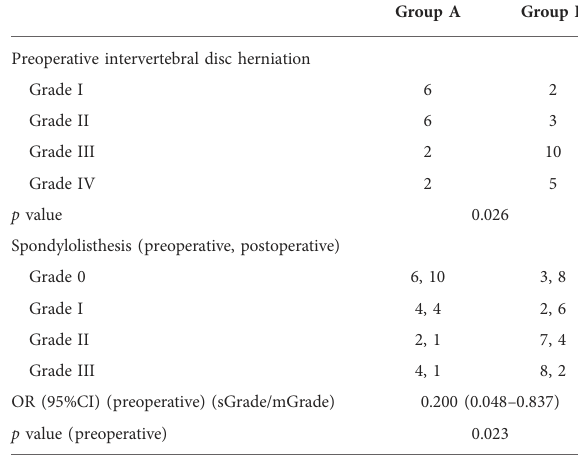
TABLE 2 Demographic characteristics of patients (mean±SD or n ). TABLE 4 Radiographic assessment ( n